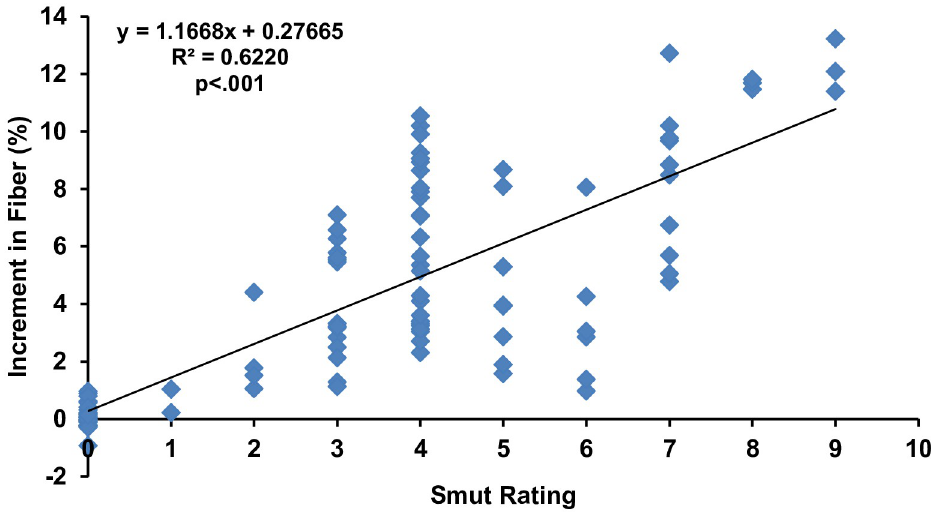
Fig 3. Regression analysis of fiber percentage with whip smut disease rating. Note: The smut rating is not a linear scale. It’s based on the transformation explained in methods from linear incidence value to the rating. Accordingly, the resulting disease incidences were converted into 0–9 disease rating scale [41], where 0: no disease, 1: 0.1–2.5%, 2: 2.6– 5.5%, 3: 5.6–7.5%, 4: 7.6–12.5%, 5: 12.6–15.5%, 6: 15.6–18.0%, 7: 18.1–22.5%, 8: 22.6–25.5% and 9: 25.6–100%.